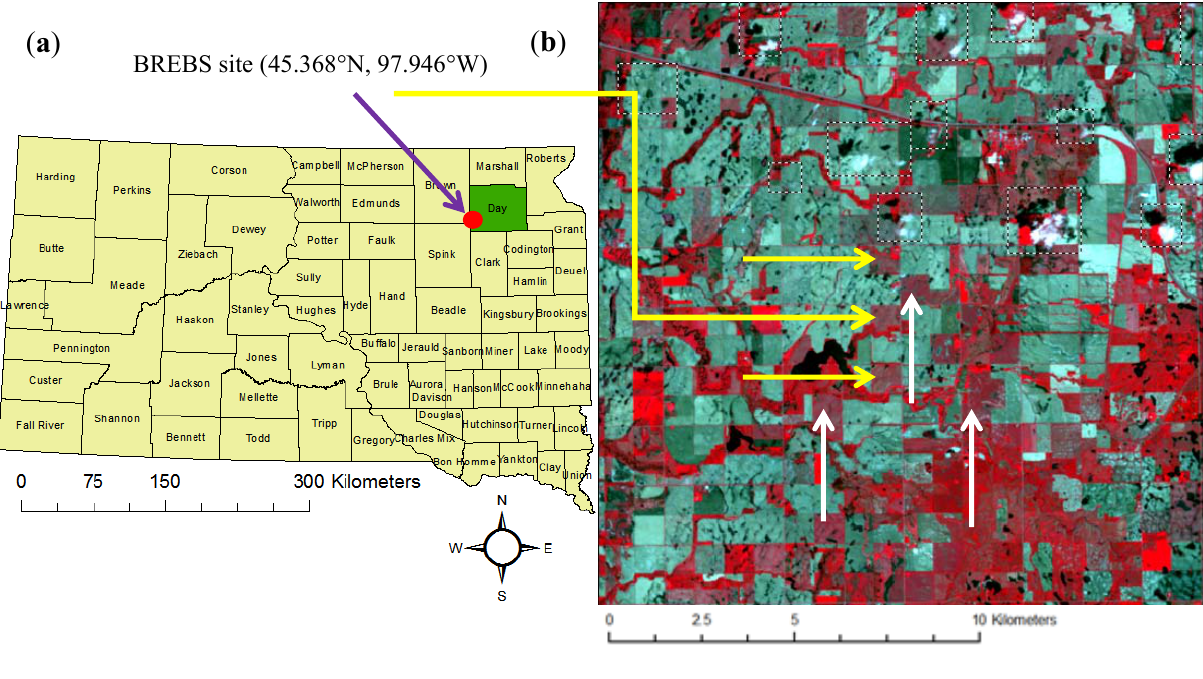
Figure 1. ( a ) Location of the study site within South Dakota with county boundaries indicated. The arrow points to the study area. BREBS site is located at 45.368°N, 97.946°W. ( b ) The false color image of the study area from 4 June 2011, dotted-line boxes show the areas to be masked for gap-filling. The three yellow arrows indicate the three fields that were planted into cover crop after spring wheat, with the BREBS located in the middle field. The three white arrows indicate three fields that were not planted into cover crop after spring